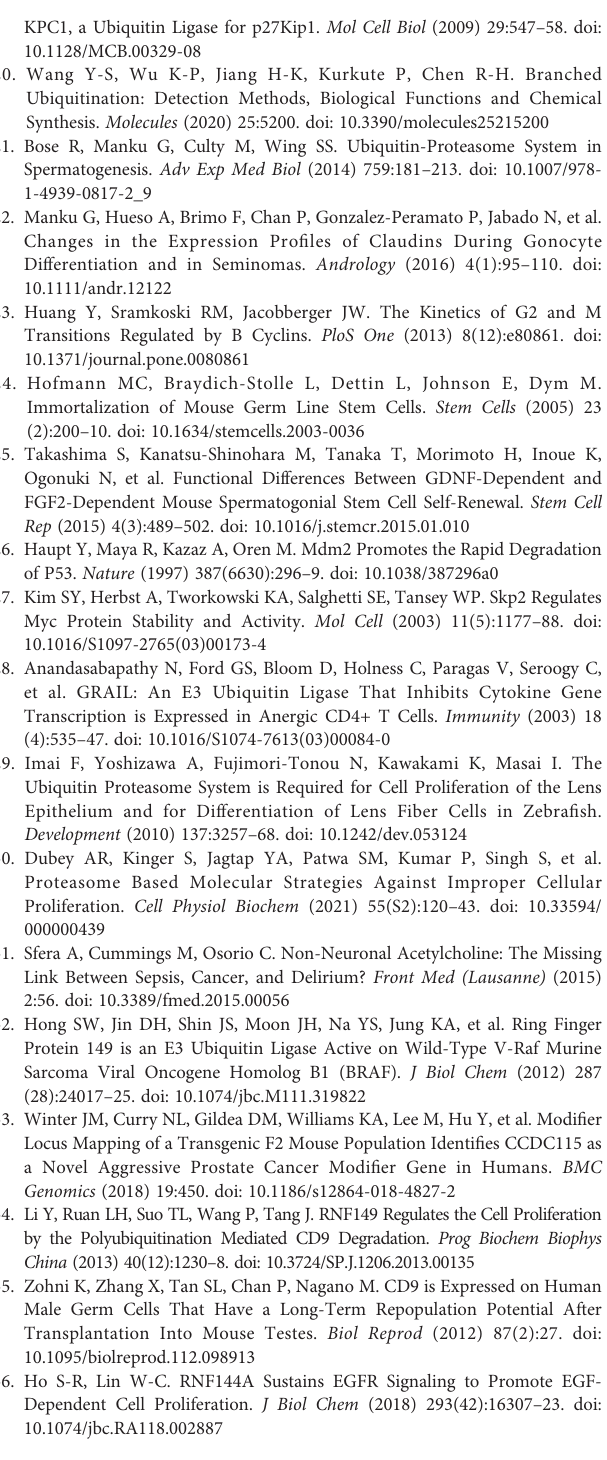
Supplementary Figure 2 | Gene map of EGFP-RNF149 plasmid. (A) RNF149 EGFP-VA1 gene map. (B) RNF149 EGFP-VA2 gene